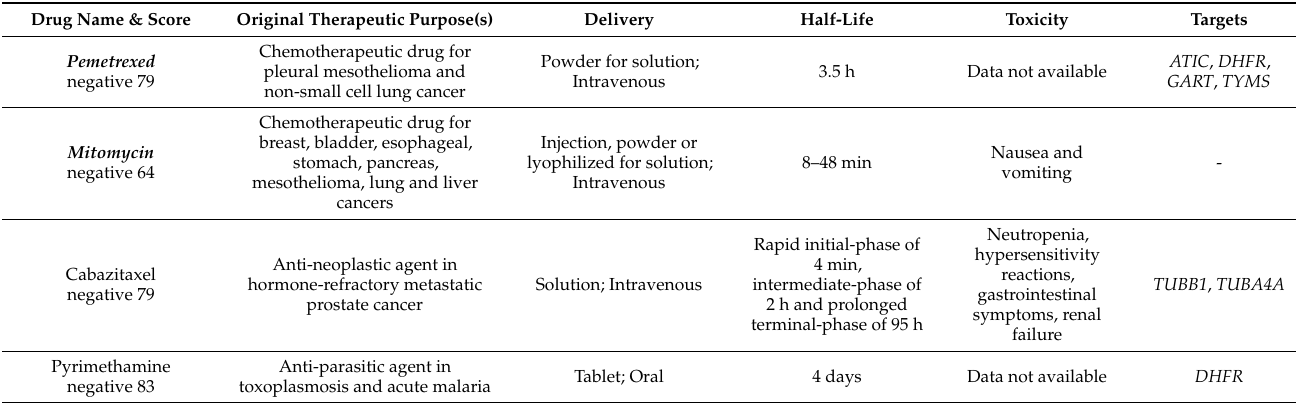
Figure 5. Malignant pleural mesothelioma (MPM) Drug-Protein Interactome: The network shows the drugs (green color nodes) that target the proteins in the MPM interactome. Larger green nodes correspond to drugs that target the anatomic category ‘antineoplastic and immunomodulating agents’. The color legend for genes (proteins) is as shown in Figure 1, with MPM genes in dark blue, their known interactors in light blue and novel interactors in red. Table 3. Pharmacokinetic details of known mesothelioma drugs and the drugs that are presented as candidates for repurposing. Known mesothelioma drugs are shown in bold italics. Score corresponds to scaled correlation score with lung cancer expression studies from BaseSpace (NextBio)